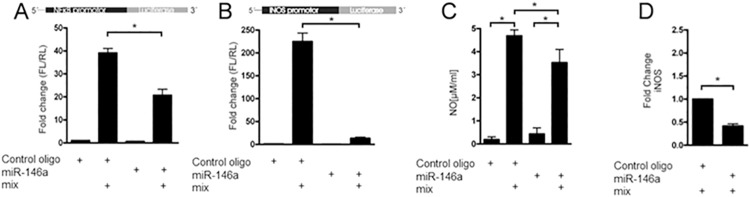
miR-146a-5p overexpression inhibits NF-κB signaling and blocks iNOS expression.(A) The Luciferase promoter assay was performed in INS1 cells with a NF-κB promoter construct driving Firefly luciferase. The cells were pre-treated with transient transfection mix containing both miR-146a-5p promoter construct and a Renilla construct as internal control. Additionally, the INS1 cells were transiently transfected with a control oligo or a synthetic miR-146a-5p oligo, and exposed to media with or without IL-1β (160 pg/ml) for 6 h. The relative fold change in ratio between Firefly/Renilla luciferase is plotted. Mean ± SEM (n = 4). (B) iNOS activity was measured by luciferase assay as described above. Mean ± SEM (n = 4). (C) NO in medium from INS1 cells transfected with either a control oligo or a synthetic miR-146a-5p 24 h prior to exposure to IL-1β (160 pg/ml) and IFN-γ (5 ng/ml). Mean ± SEM (n = 4). (D) iNOS protein expression was analyzed by Western blotting from INS1 cells transfected with either a control oligo or a synthetic miR-146a-5p 24 h prior to exposure to IL-1β (160 pg/ml) and IFN-γ (5 ng/ml). Mean ± SEM (n = 4). *p<0.05.